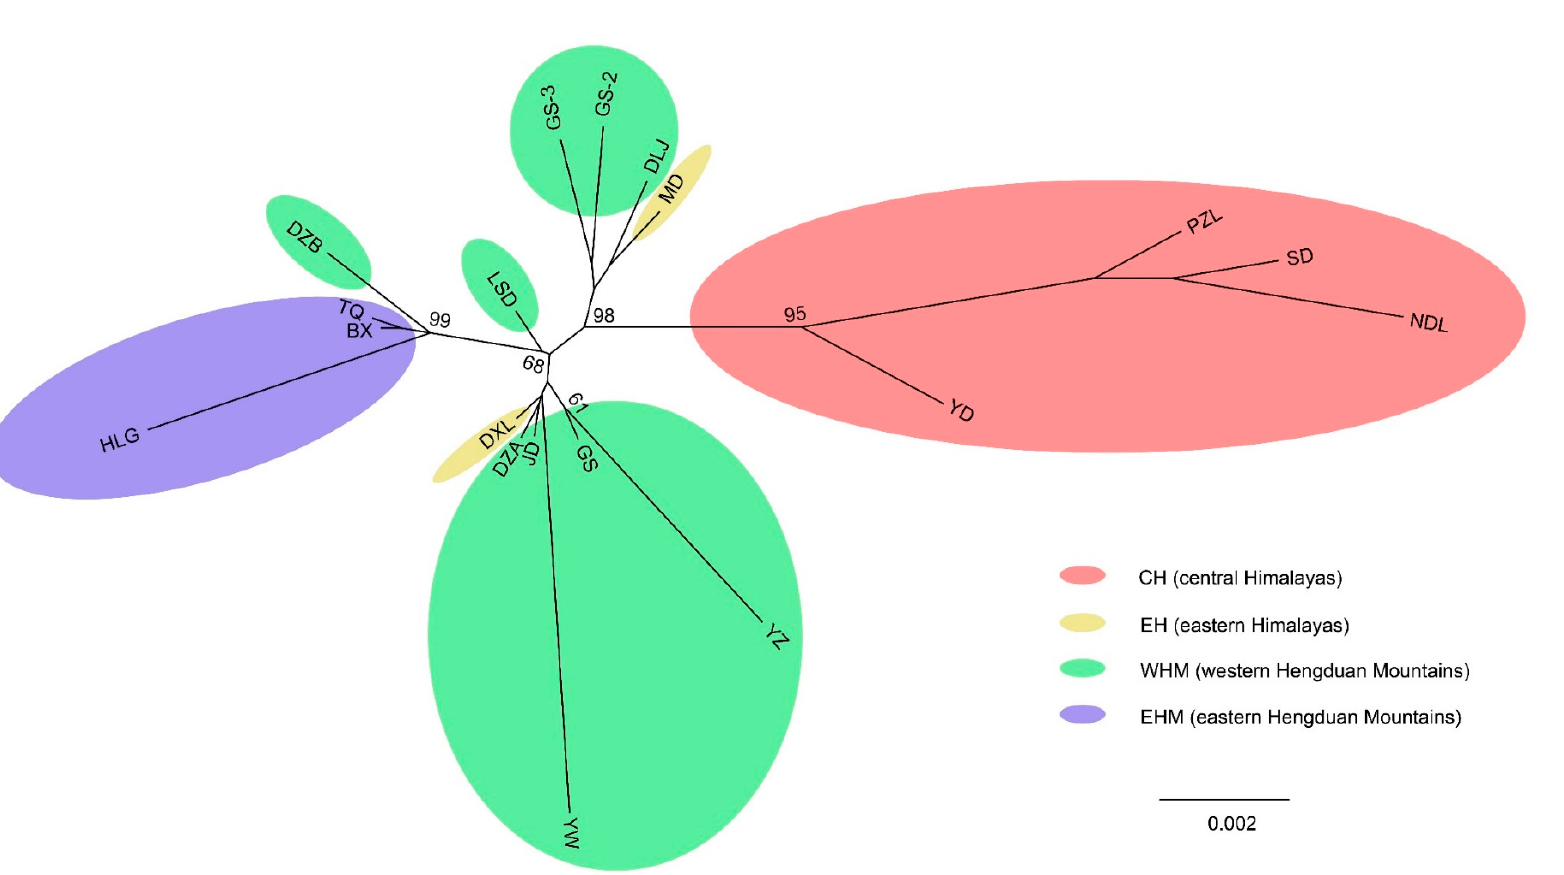
Figure 2. Maximum likelihood (ML) tree of Gaultheria nummularioides with one-individual sampling for each population based on 22 cpDNA regions. The numbers above each branch represent ML bootstrap values. CH, EH, WHM, and EHM represent the central Himalaya, eastern Himalaya, western Hengduan Mountains, and eastern Hengduan Mountains, respectively. GS, Population GS (voucher: L. Lu et al., 2006-01-21); YW, Population YW (L. Lu et al., LL-07010); JD, Population JD (L. Lu et al., 06-18A); HLG, Population HLG (L. Lu et al. LL-2011-27); BX, Population BX (L. Lu et al. LL-2011-43); TQ, Population TQ (L. Lu et al. LL-2011-38); DXL, Population DXL (L. Lu et al. LL-07096); YD, Population YD (L. Lu et al. GLM-102752); GS-2, Population GS-2 (L. Lu et al. LL-2013-24); GS-3, Population GS-3 (L. Lu et al. LL-2013-29); YZ, Population YZ (L. Lu et al. LL-2014-57); DZA, Population DZA (L. Lu et al. LL-2014-14A); DZB, Population DZB (L. Lu et al. LL-2014- 14B); DLJ, Population DLJ (L. Lu et al. LL-2014-26); LSD, Population LSD (L. Lu et al. LL-2014-32); MD, Population MD (L. Lu et al. LL-2018-7); NDL, Population NDL (L. Lu et al. LL-2018-15); PZL, Population PZL (L. Lu et al. LL-2018-17); SD, Population SD (L. Lu et al.